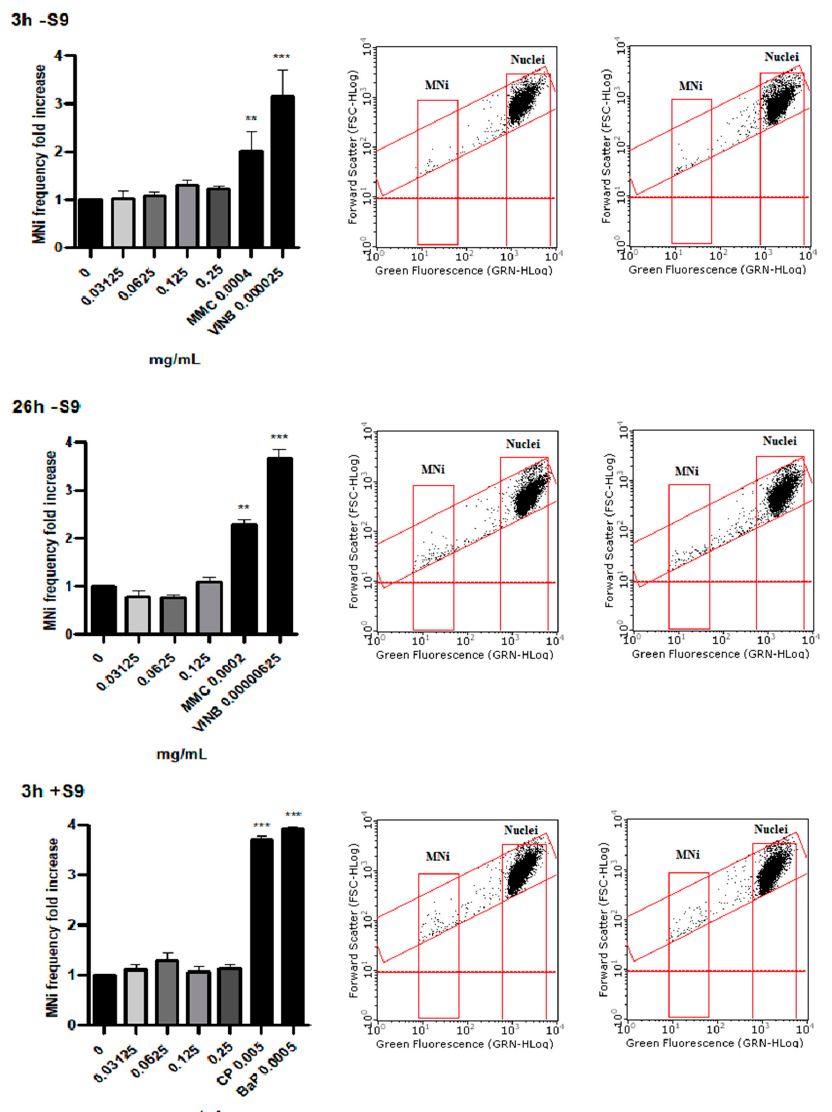
Figure 3. MNi frequency fold increase on TK6 cells after 3 h − S9 mix, 3 h +S9 mix and 26 h − S9 mix treatment with the SMD or positive controls (MMC, VINB, CP or BaP) at the indicated concentrations compared to the concurrent negative control (0 mg/mL). Each bar represents the mean ± SEM of at least three independent experiments. Data were analysed using repeated ANOVA, followed by Dunnet post-test. ** p < 0.01 vs. (0 mg/mL); *** p < 0.001 vs. (0 mg/mL). Representative FCM dot plots of nuclei and MNi in cultures treated with SMD 0.125 mg/mL (right dot plot) and in the concurrent negative control culture (left dot plot).